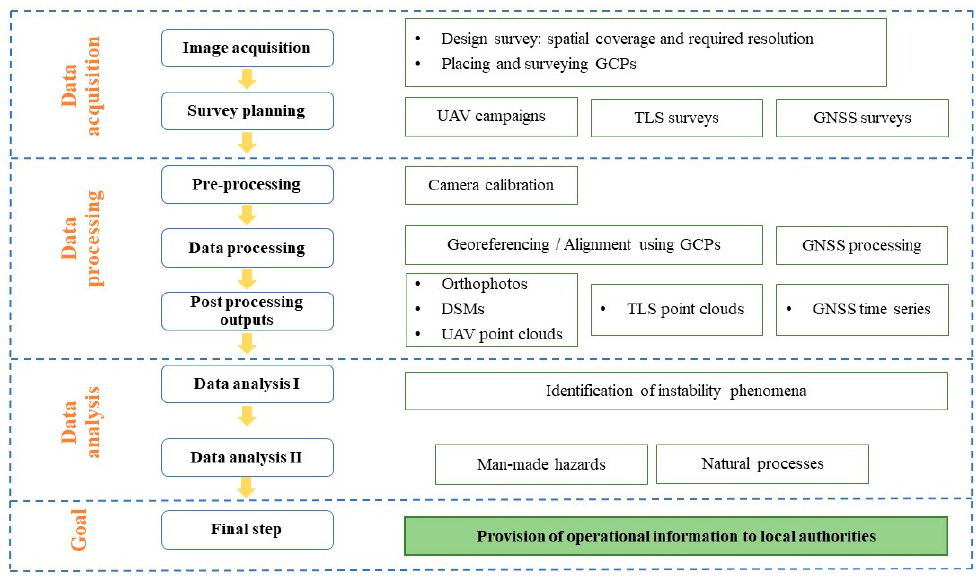
Figure 6. Flowchart depicting the applied methodology.